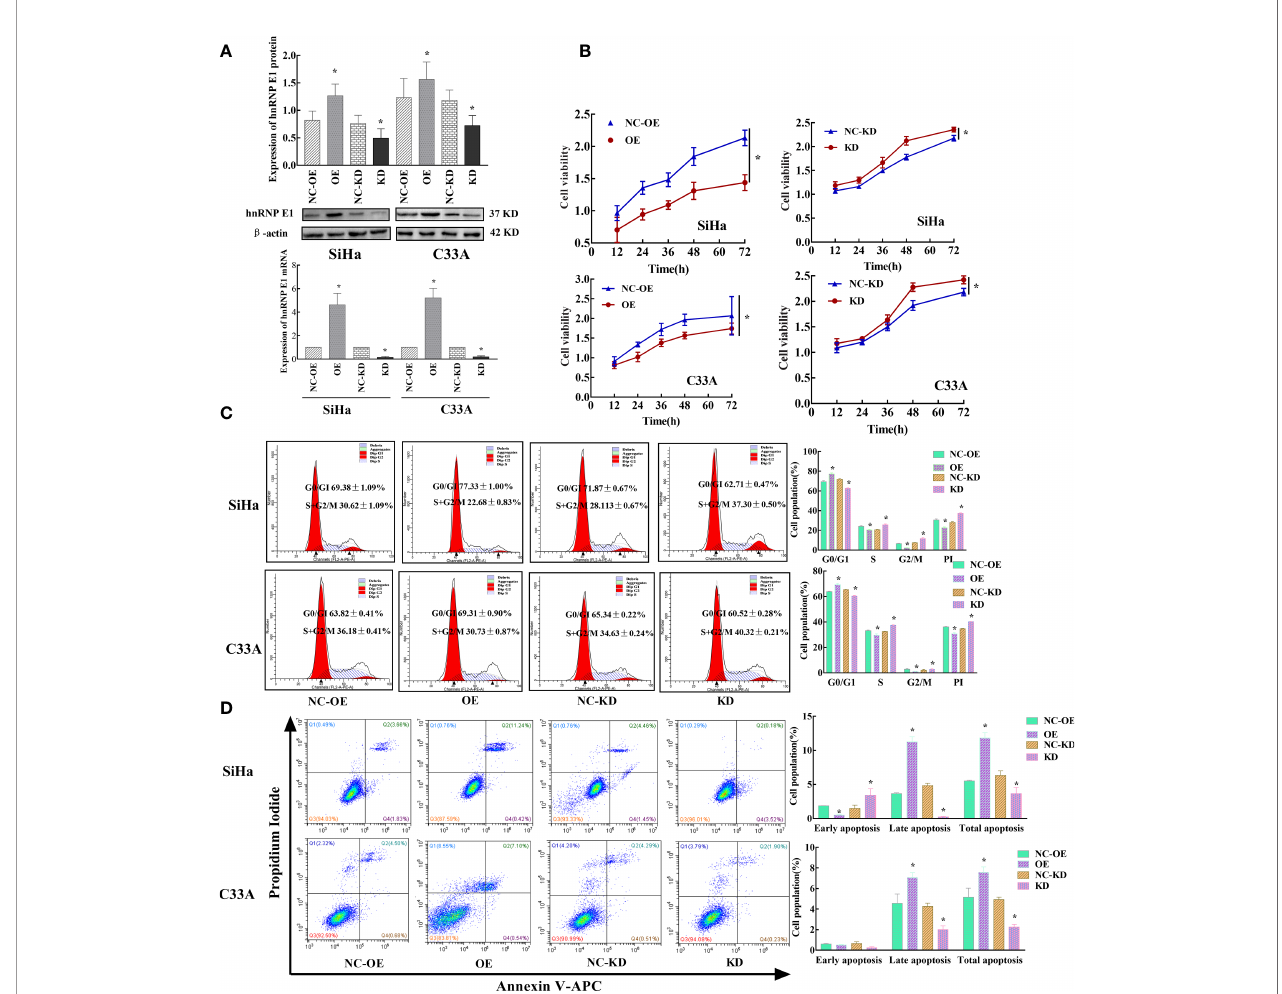
FIGURE 5 | Effects of hnRNP E1 on cell biological function in cervical cancer cell lines. Note: OE indicates hnRNP E1 overexpression group and NC-OE indicates the relative control group. KD indicates hnRNP E1 knockdown group and NC-KD indicates the relative control group. * P < 0.05. (A) Stably transfected hnRNP E1-modi fi ed cervical cancer cells were identi fi ed by RT-qPCR and western blotting. (B) hnRNP E1 overexpression strongly suppressed cell viabilities in SiHa and C33A cells. hnRNP E1 knockdown markedly enhanced cell viabilities in SiHa and C33A cells. (C) hnRNP E1 arrests the cell cycle from the G0/G1 to the S phase. (D) hnRNP E1 promotes cell